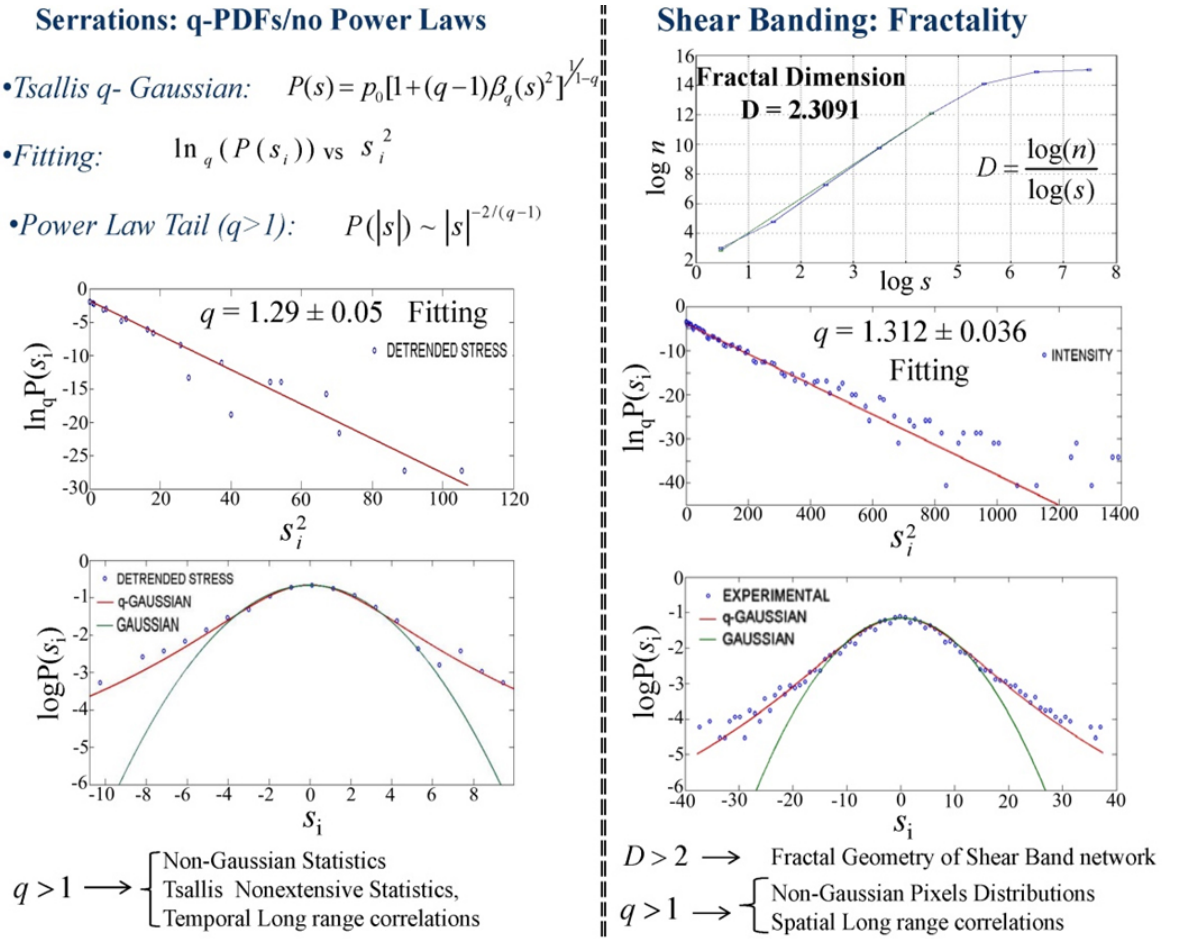
Figure 7: Tsallis q-statistics analysis for power-like laws and fractality of the experimental data presented in Figure 6. For related details the reader can consult [7] and references quoted therein.